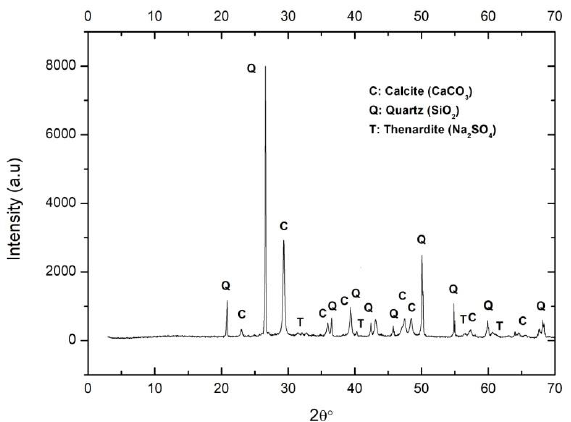
Figure 3. XRD of mortar sample. C: Calcite, Q: Quartz, T: Thenardite.